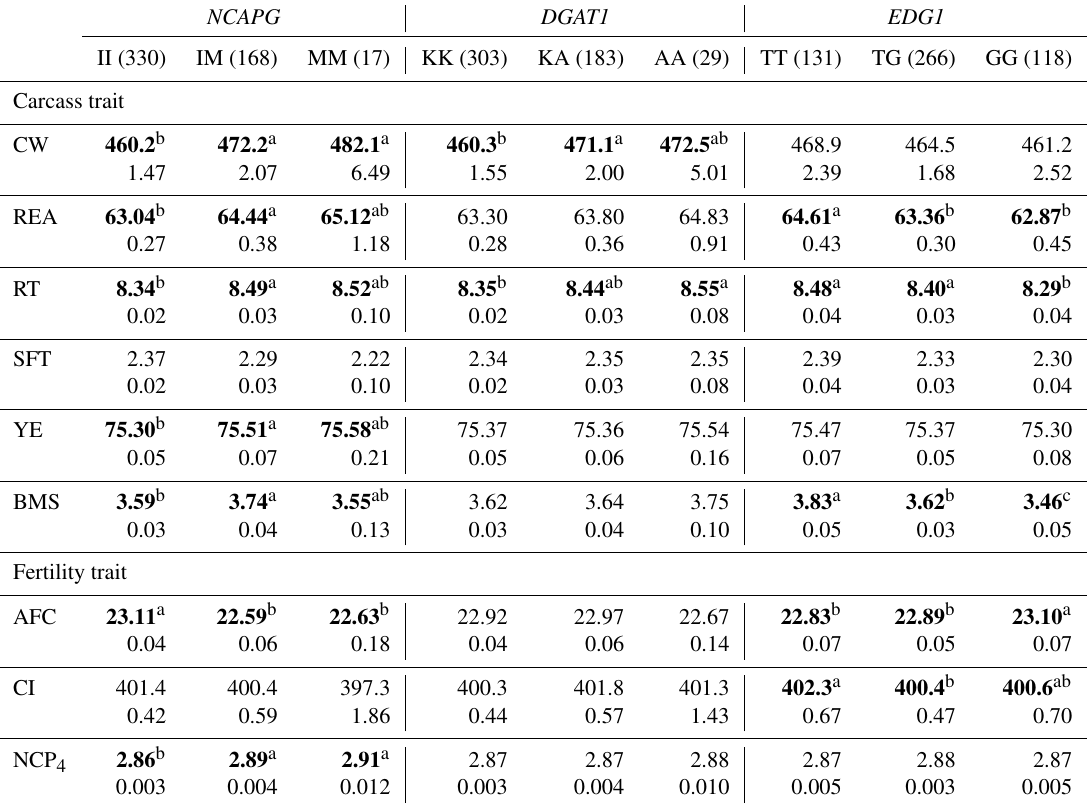
Table 6. The effect of the markers within NCAPG , DGAT1 , and EDG1 genes on carcass and fertility traits in the Japanese Black cattle population ( n = 515).